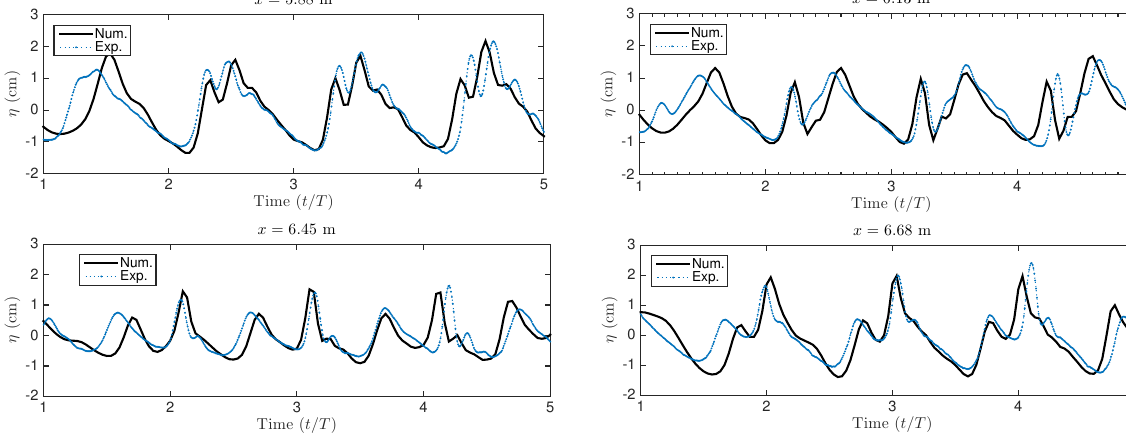
Figure 9. Experimental and numerical results of the water elevation for Test B using Mesh 2 ( ∆ x = 2.5 cm and ∆ z = 0.3